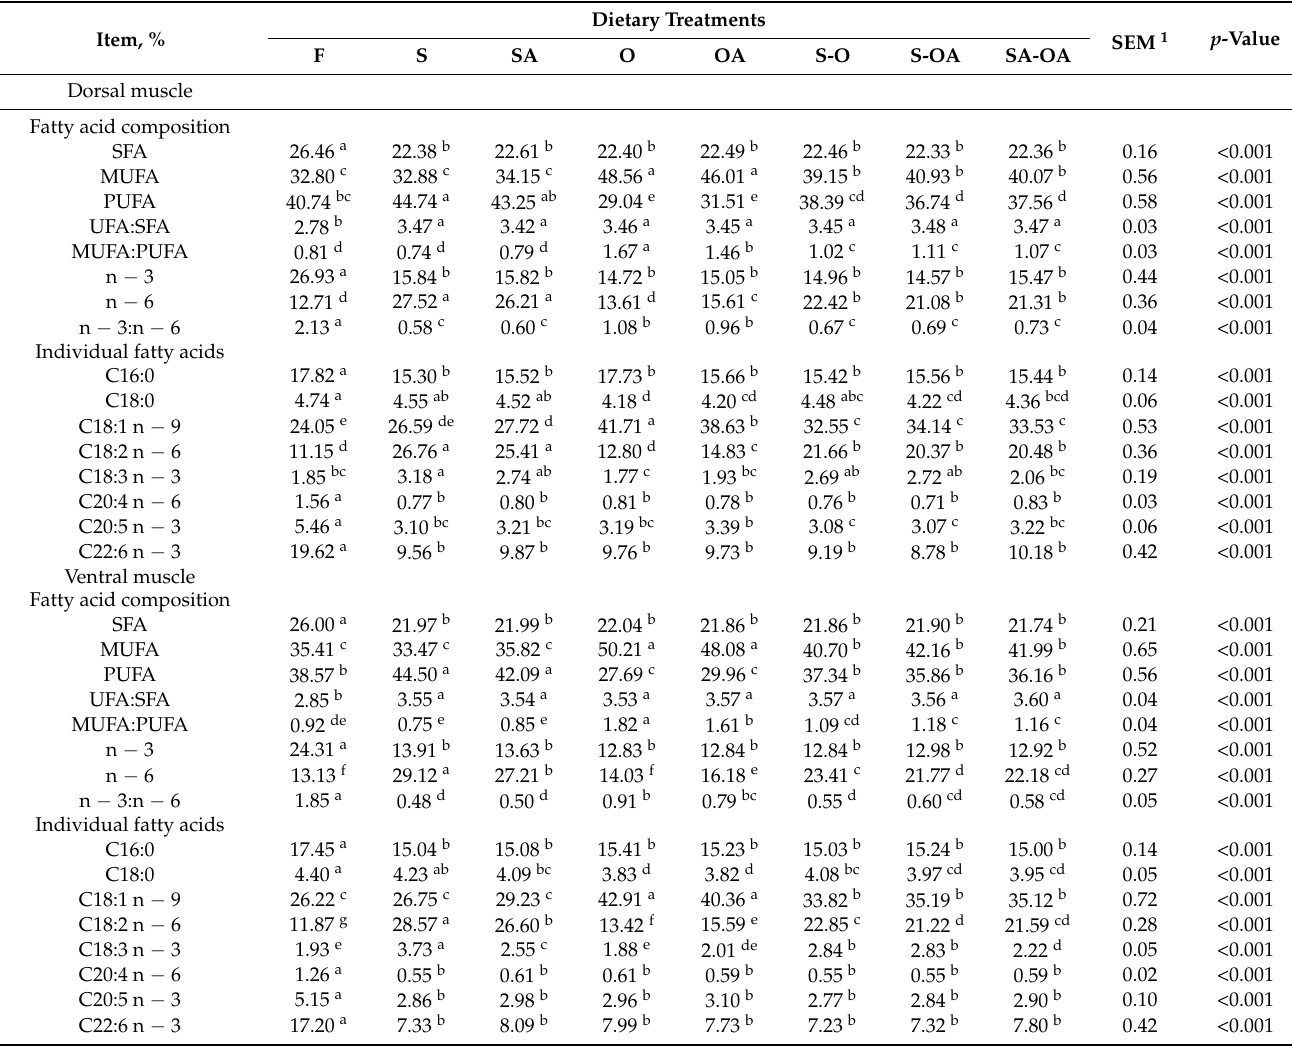
Table 7. Fatty acid composition of dorsal and ventral muscle from European seabass according to different dietary